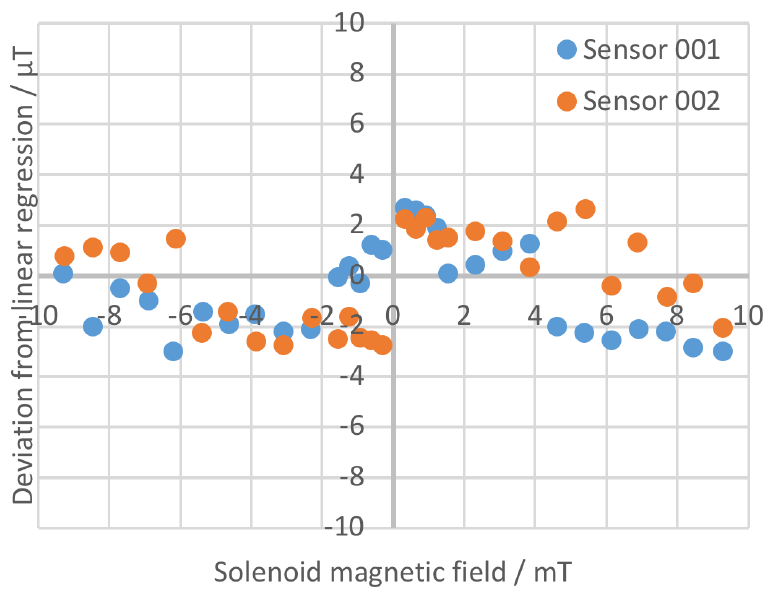
Figure 10. Linearity test results at the Stefan Mayer Instruments GmbH factory.